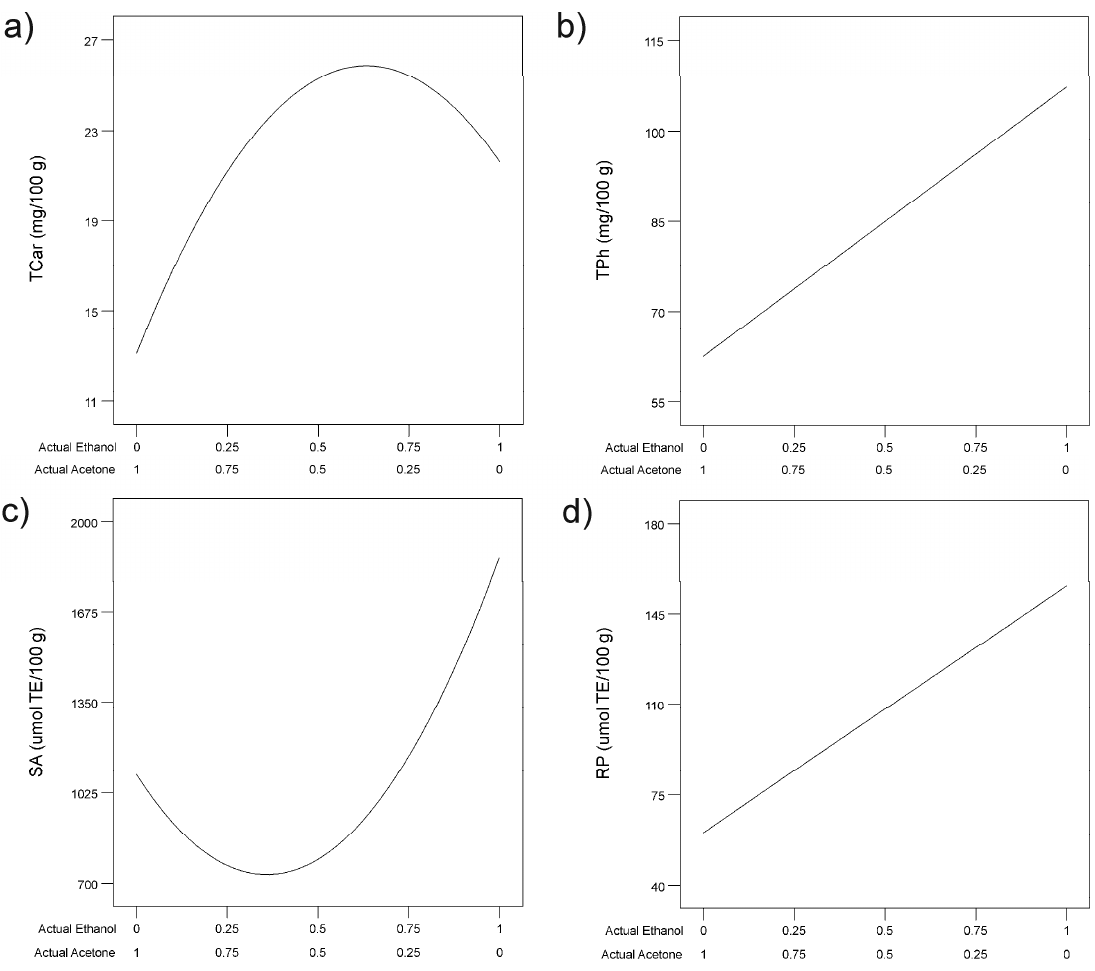
Figure 2. Total carotenoid ( a ) and polyphenol contents ( b ), scavenging activity ( c ), and reducing power ( d ) in ASE extracts obtained with acetone/ethanol mixtures.